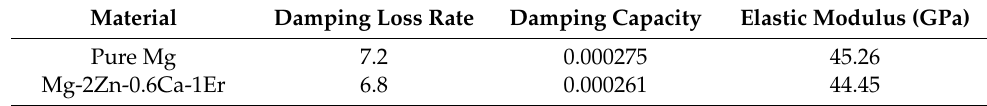
Table 3. Elastic modulus and damping characteristics of pure Mg and Mg-2Zn-0.6Ca-1Er.